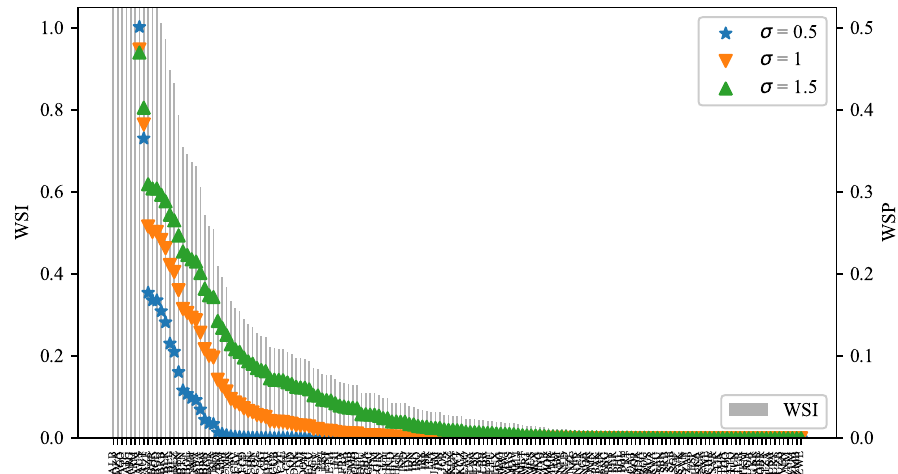
Figure A1. The water stress index(WSI) for different countries and the virtual water scarcity probability (WSP) under different σ values.